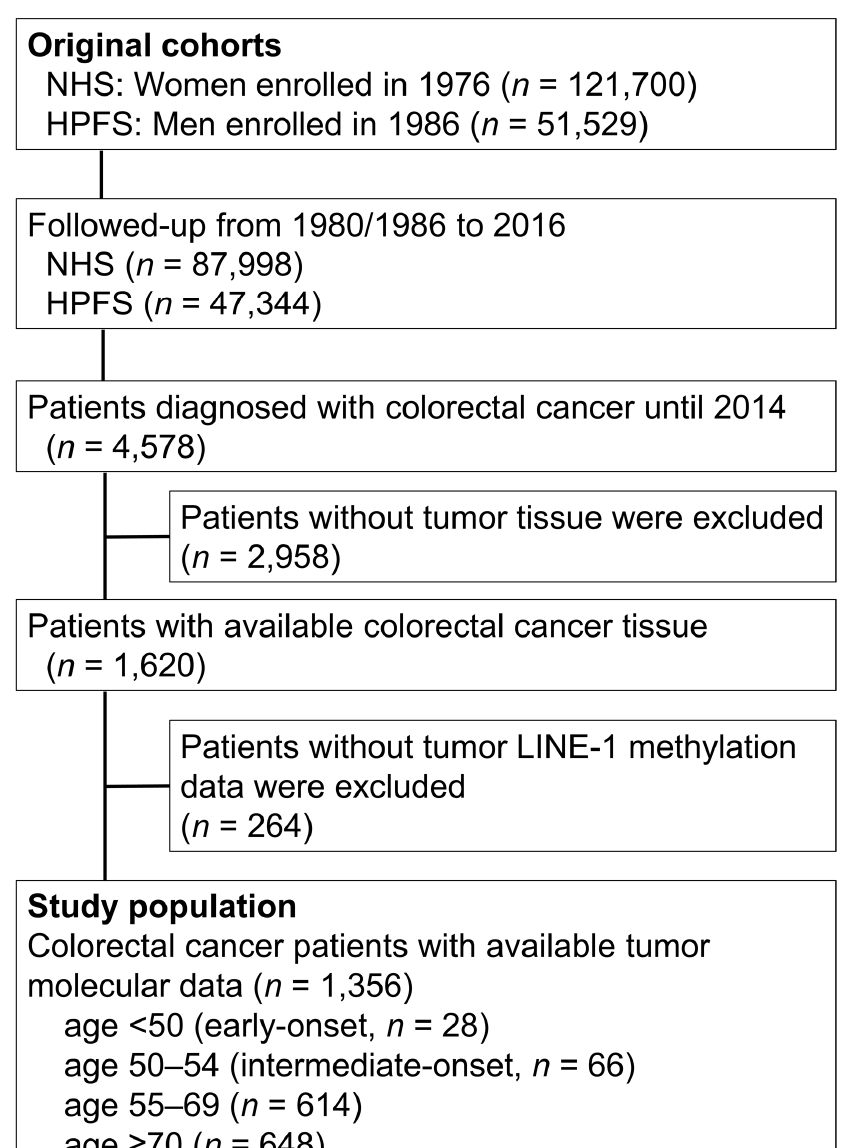
Figure 1. Flow chart of case selection in the Nurses’ Health Study and the Health Professionals Follow- up Study. Abbreviations: HPFS, Health Professionals Follow-up Study; LINE-1, long interspersed nucleotide element-1; NHS, Nurses’ Health